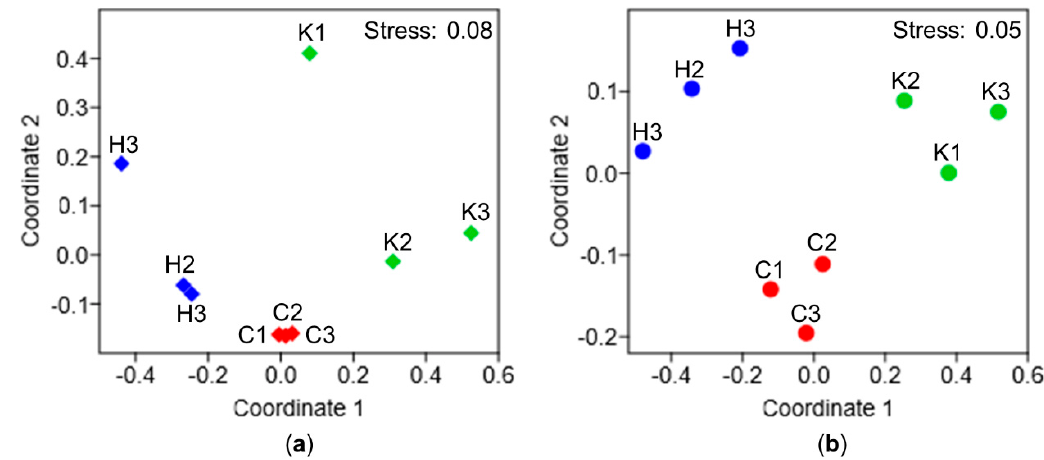
Figure 4. Comparative chemical profiling of geographically distinct C. intestinalis populations. Chemical profiling was performed with population level extracts. The 2D nMDS plot was constructed using ( a ) the full set of detected metabolites or ( b ) a restricted dataset containing only core metabolites detected in all samples. Similarity matrices were calculated with the Bray-Curtis similarity index based on the peak area. Sampling locations are color-coded: red: Canada (replicate C1–C3), blue: Helgoland (replicate H1–H3), green: Kiel (replicate K1–K3).